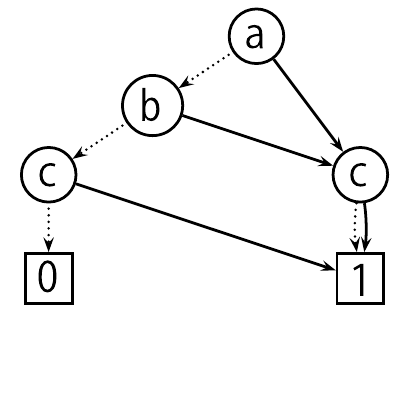
Figure 3. The reduced ZDD representing Z ( 1 ) = {{ a } , { b } , { c } , { a , c } , { b , c }} . E = { a , b , c } where a < b < c . Dotted lines represent 0 -arcs and solid lines represent 1